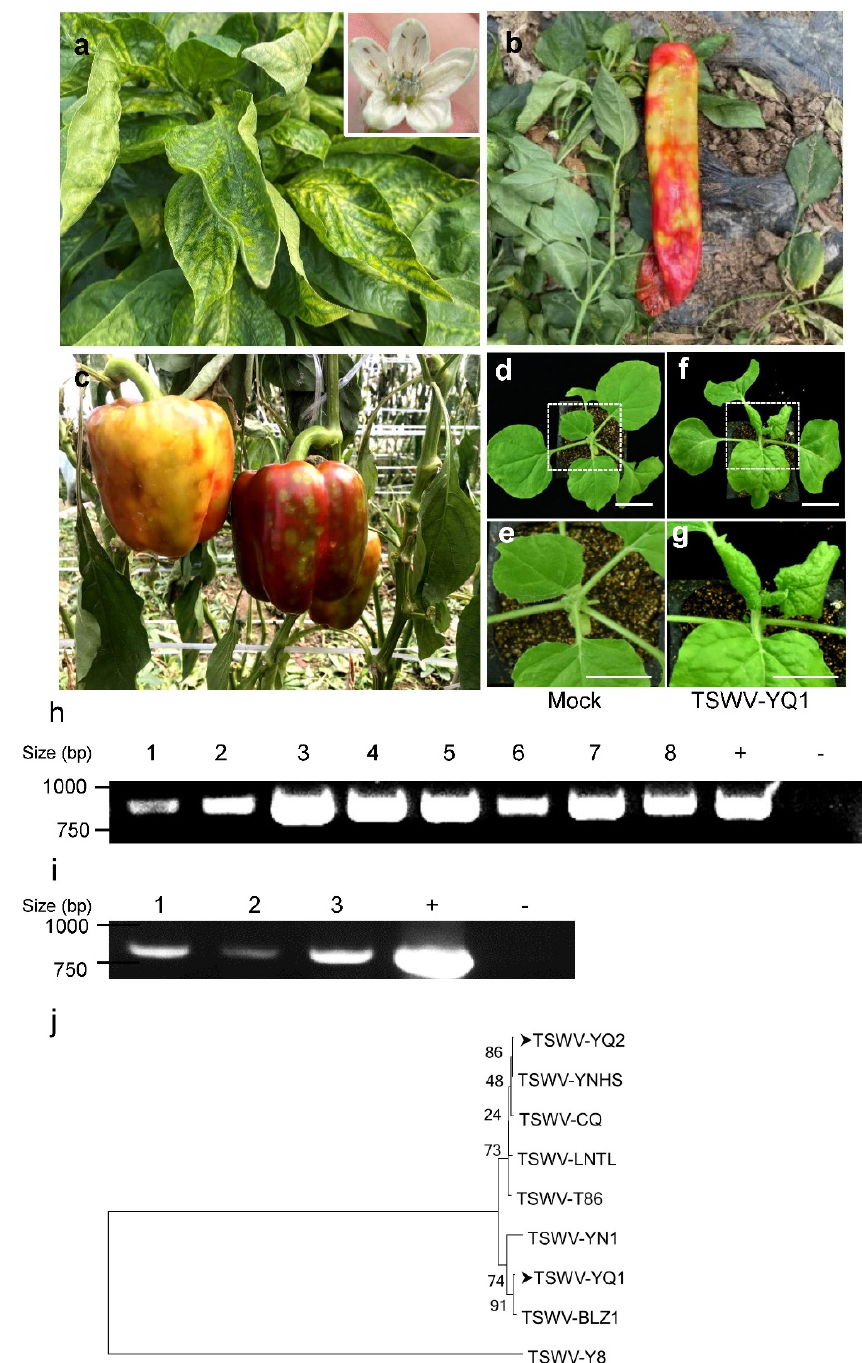
Figure 1. Identification of TSWV as the causal pathogen for a severe pepper disease in the 2020–2021 growing seasons in Yanqing District, Beijing. ( a ) Typical disease symptoms of pepper leaves